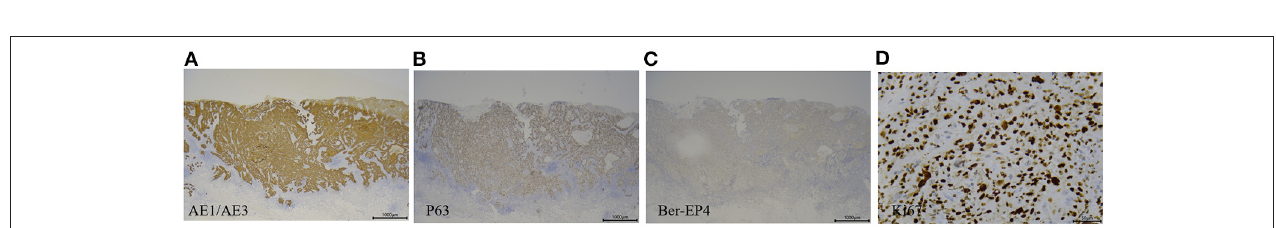
FIGURE 2 | Representative images showing the histologic appearance of a tumor specimen from patient 3. (A) Section stained with hematoxylin-eosin (magnification, × 25). (B) Section stained with hematoxylin-eosin (magnification, × 200). (C) Section stained with hematoxylin-eosin (magnification, × 400).